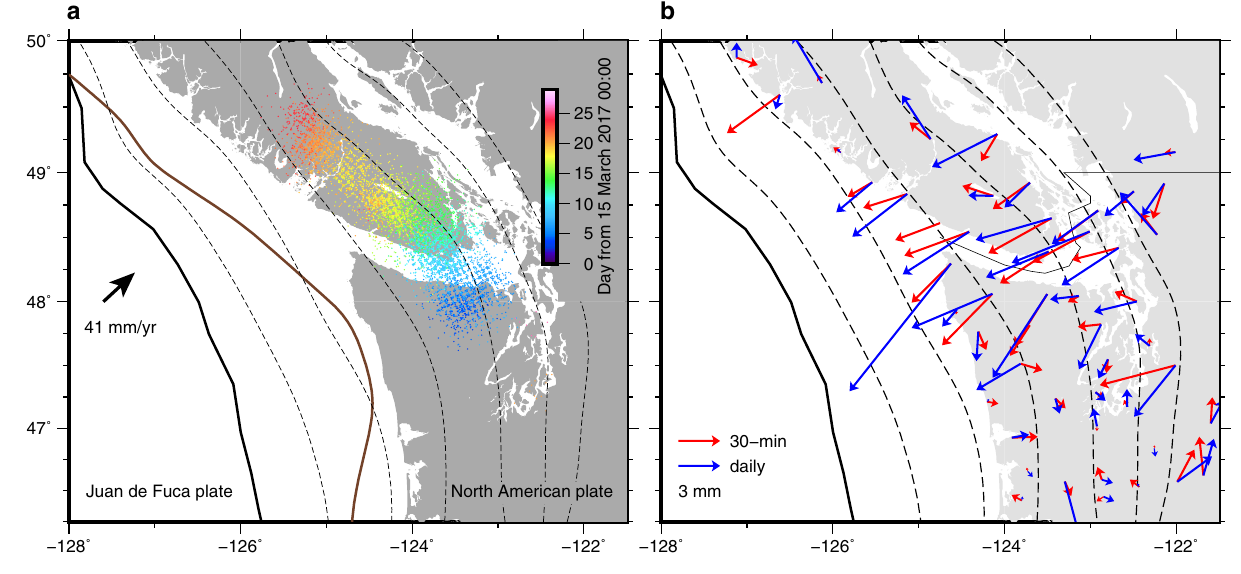
Figure 1. Tectonic setting of Cascadia subduction zone and comparison of cumulative GPS displacements derived from the 30-min and the daily data. ( a ) The solid bold black line indicates the trench of the two converging plates as labelled. The broken lines indicate slab surface depth contours (10 km interval from 10-km depth) 37 . The solid brown line outlines the interseismic locking depth 38 , defined as a contour of locking ratio = 0.7. The small dots color-coded with time indicate tremor epicentres detected by PNSN (https:// pnsn. org/ tremor; Downloaded in 25 June 2021). ( b ) Cumulative GPS displacements at selected sites using the 30-min (red) and the daily (blue) data. The cumulative displacements for the 30-min data are obtained as the difference of the initial and the final positions, which are defined as the average positions during the first (15–17 March 2017) and the last 3 days (10–12 April 2017), respectively. Outliers deviating from the average by more than 3 times of the standard deviation were removed when taking the averages. The cumulative displacements for the daily data are simply obtained by the difference of the positions at the first (15 March 2021) and the last days (12 April 2021). Prior to the displacement computation, each time series were corrected for whole network translation estimated in each slip inversion. The same figure but showing all the sites in the entire area is presented in Fig.